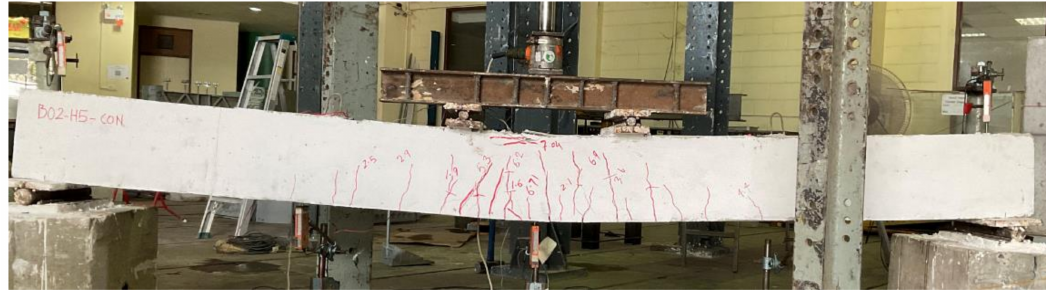
Figure 10. Failure mode of beam B02-HS50-CON.